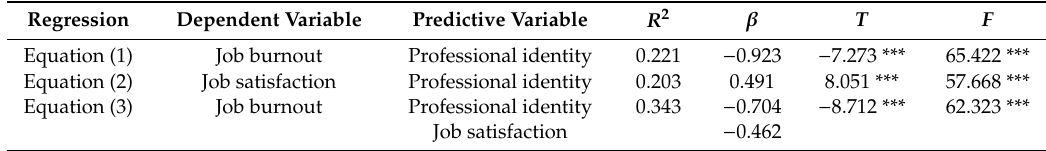
Table 2. Stepwise regression model of the mediating role of job satisfaction.